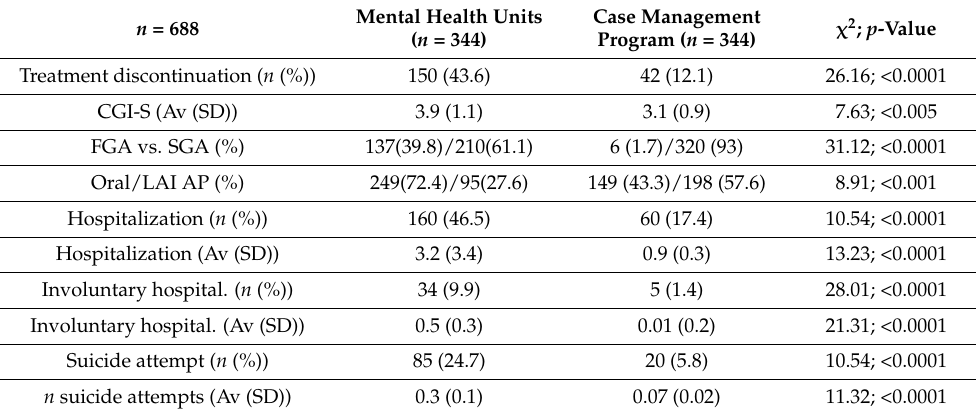
Table 2. Clinical Treatment Outcomes after 10-Year Follow-Up. n = 688